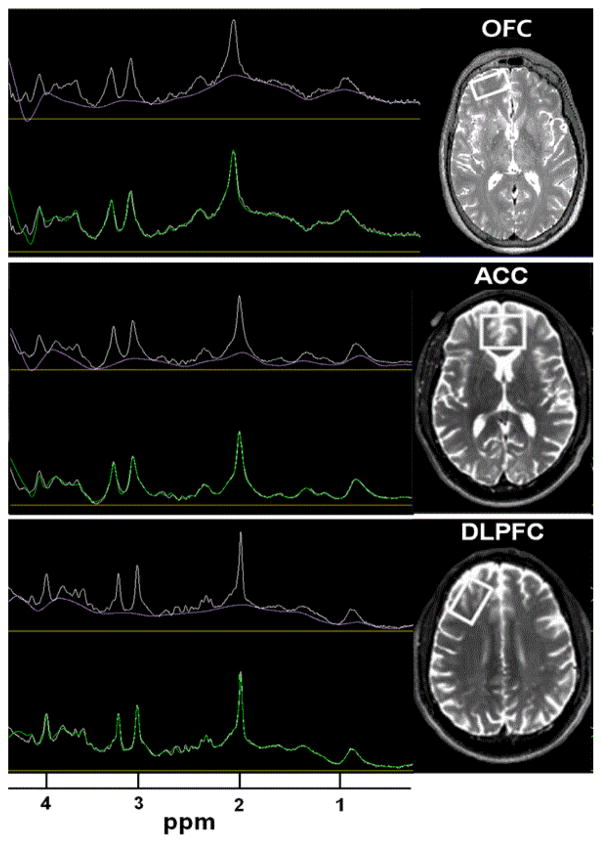
OFC compared to ACC and DLPFC VOI STEAM spectra shown as fitted after DC-correction and apodization. For all VOIs, the experimental spectra are represented in white and the fitted baseline is displayed in purple. The green line overlying the white line in the bottom spectra for each VOI represent the convergence of the summed spectral fits for each metabolite resonance.